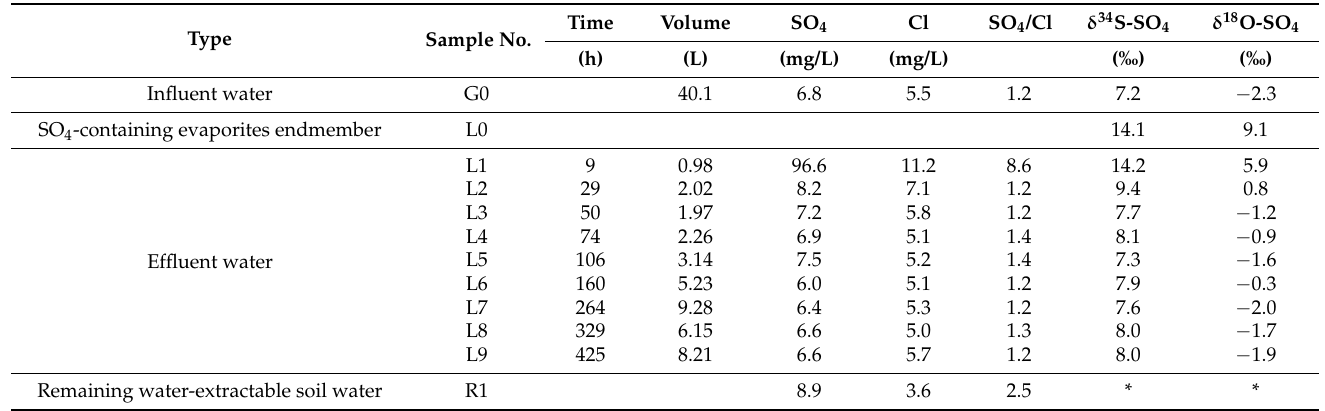
Table 2. The concentration of SO 4 , δ 34 S-SO 4 , and δ 18 O-SO 4 values of injected water, remaining water-extractable soil water, and effluent water